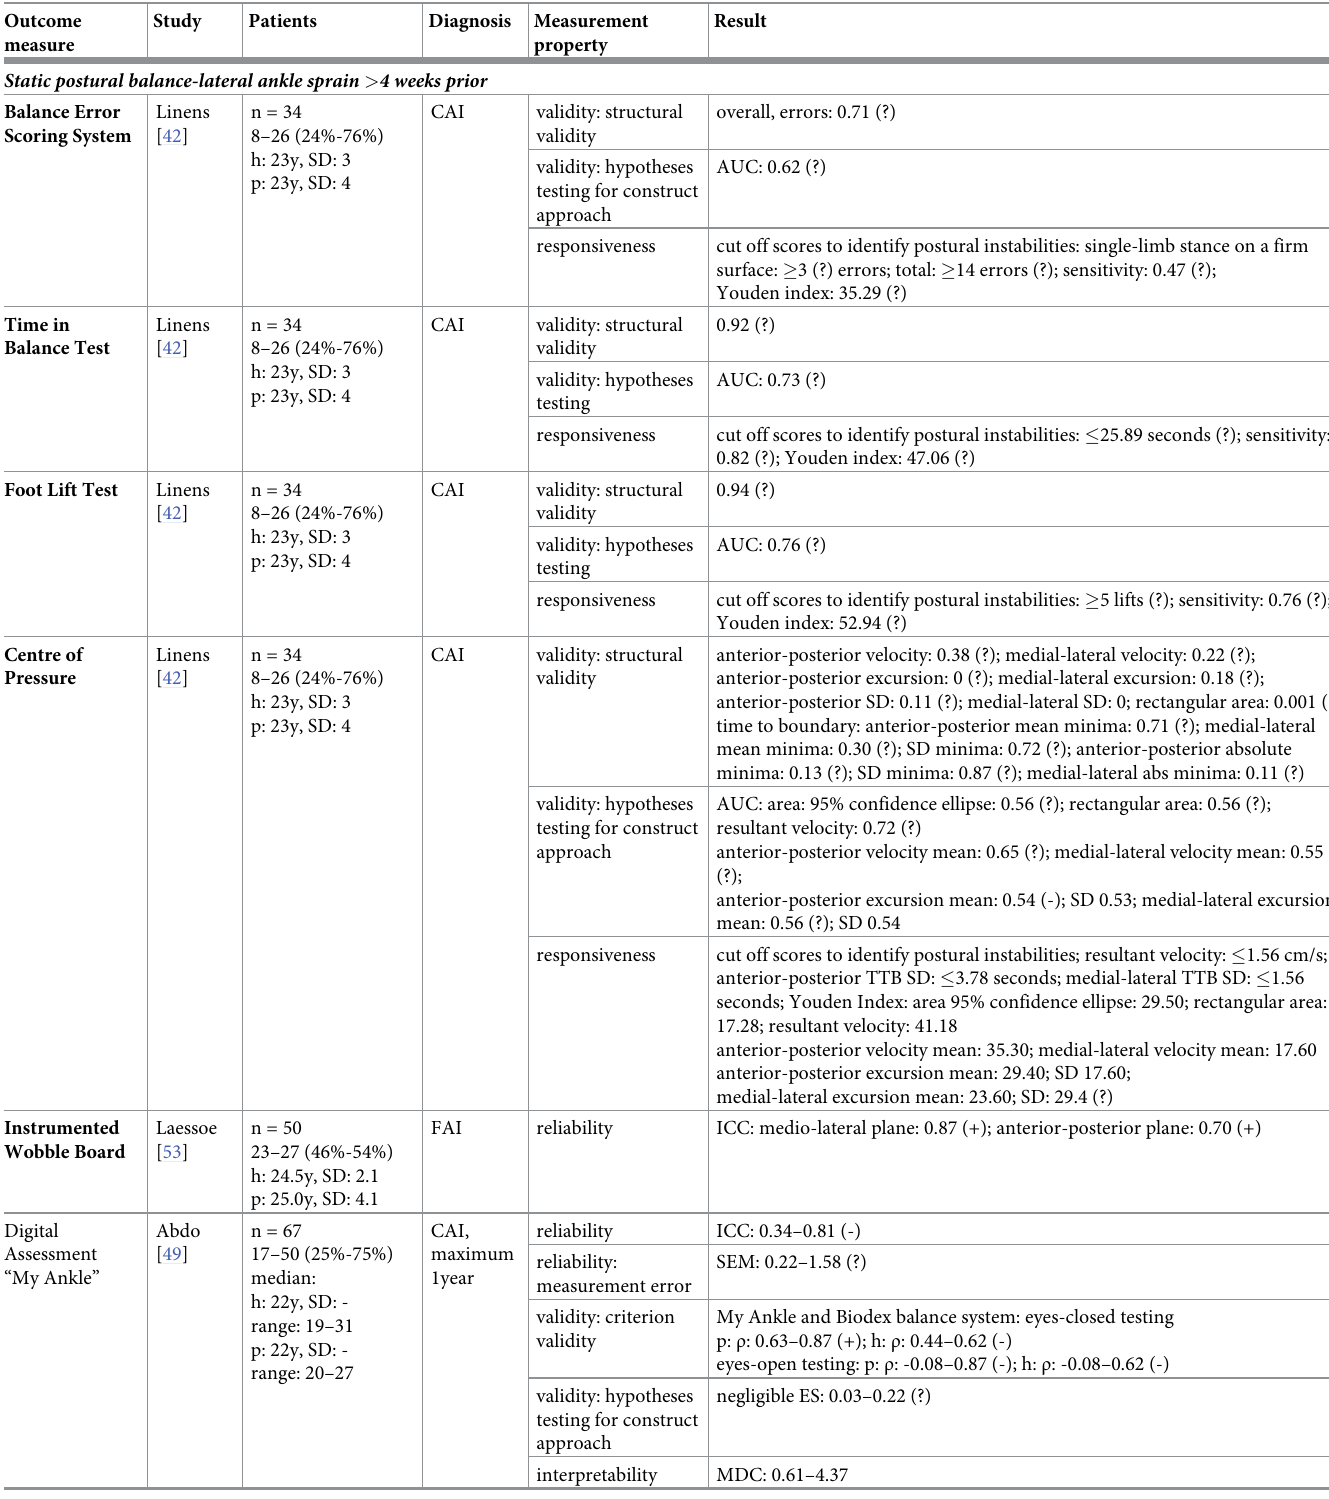
Table 7. Summary of findings. Secondary